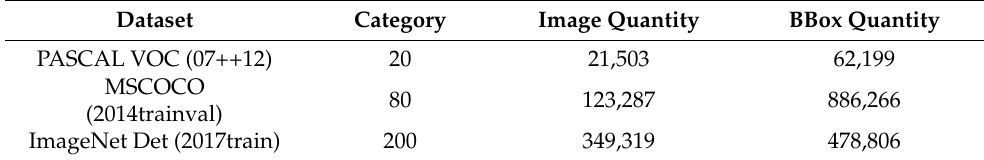
Table 1. Comparisons of open-source datasets.